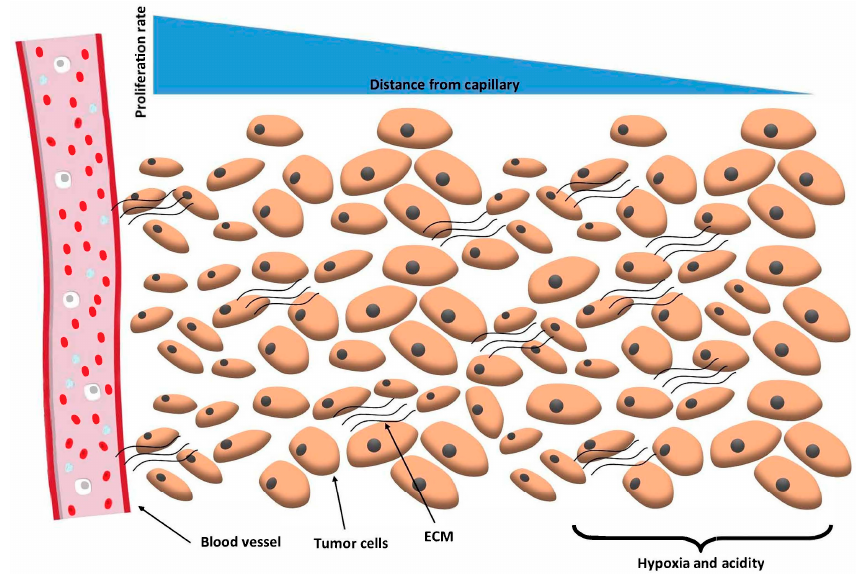
Figure 1. Blood vessels, extracellular matrix (ECM) and the tumour cell in the in vivo tumour